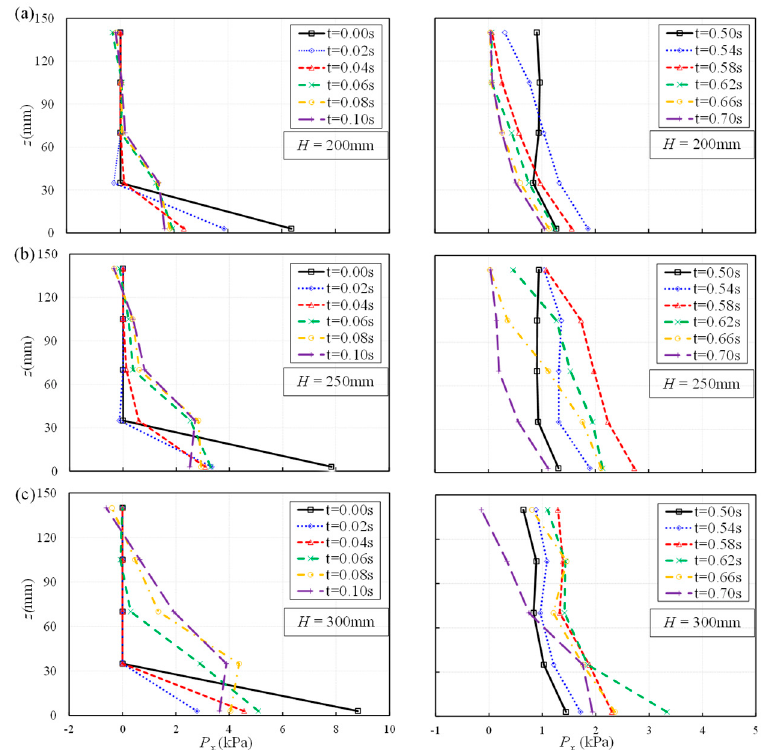
Figure 11. Vertical distributions of the dynamic pressure on the wall around the initial impact and the second pressure peak for different impoundment depths: ( a ) H = 200 m; ( b ) H = 250 mm; ( c ) H = 300 mm. The t m = 0.00 s indicates the initial impact of the bore front with the vertical wall.